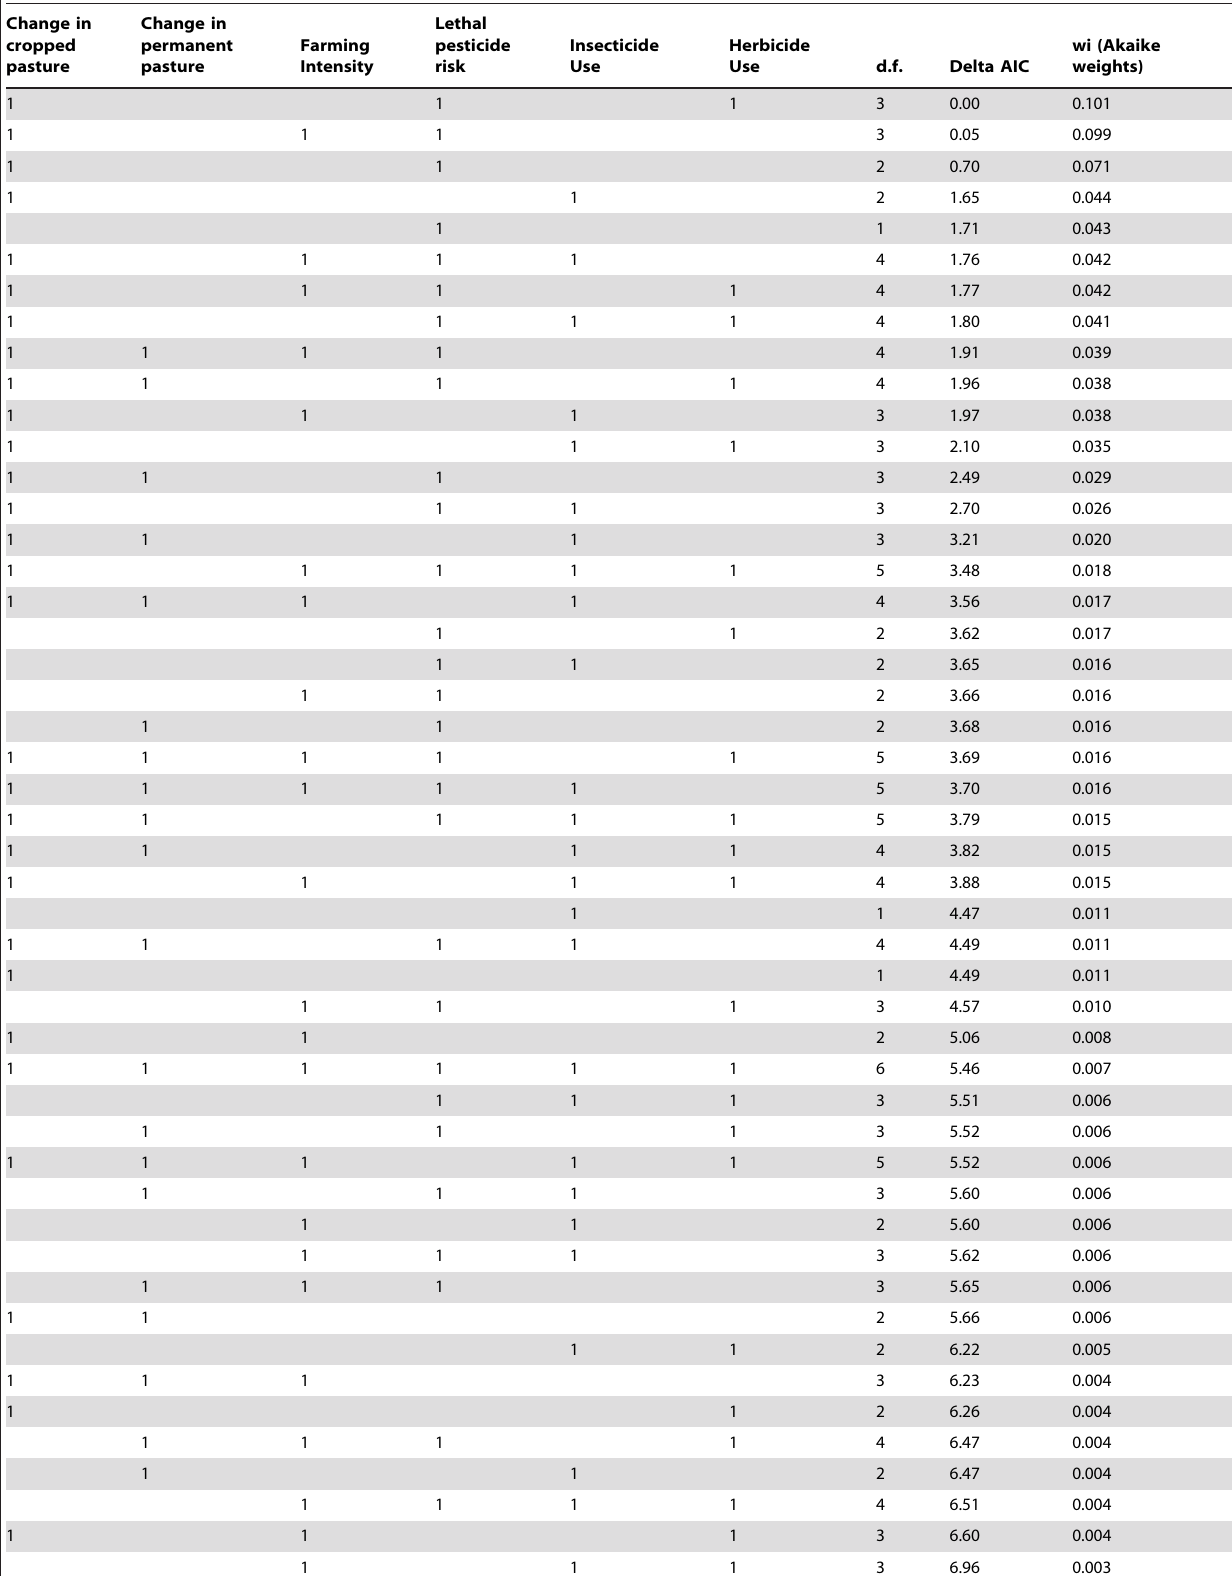
Table 4. Summary of model results for the logit regression and 5 predictor variables.